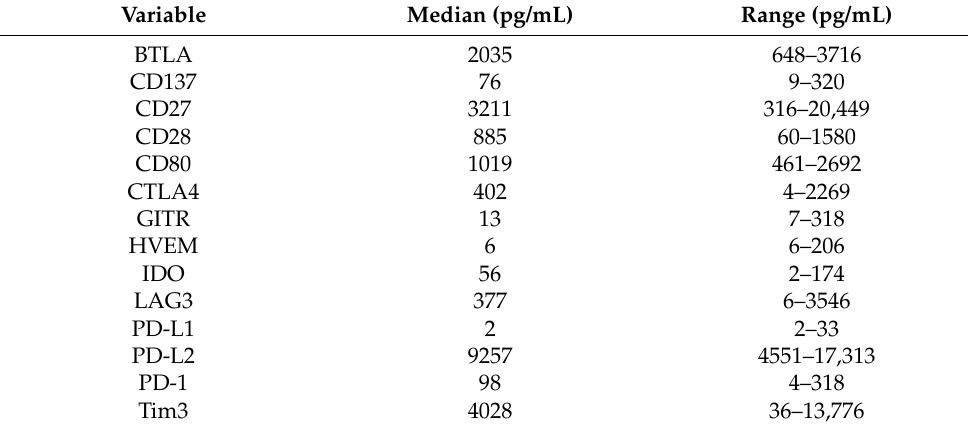
Table 2. sICs baseline